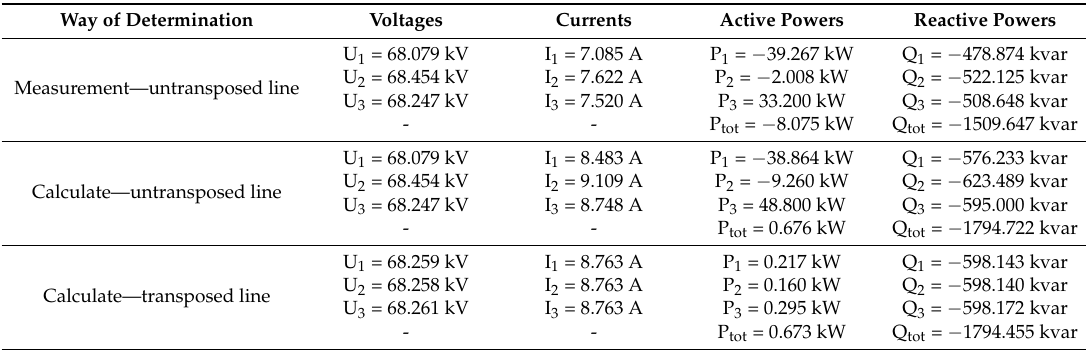
Table 1. The values of the measured and calculated electrical amounts in Section 1 (the beginning of the studied